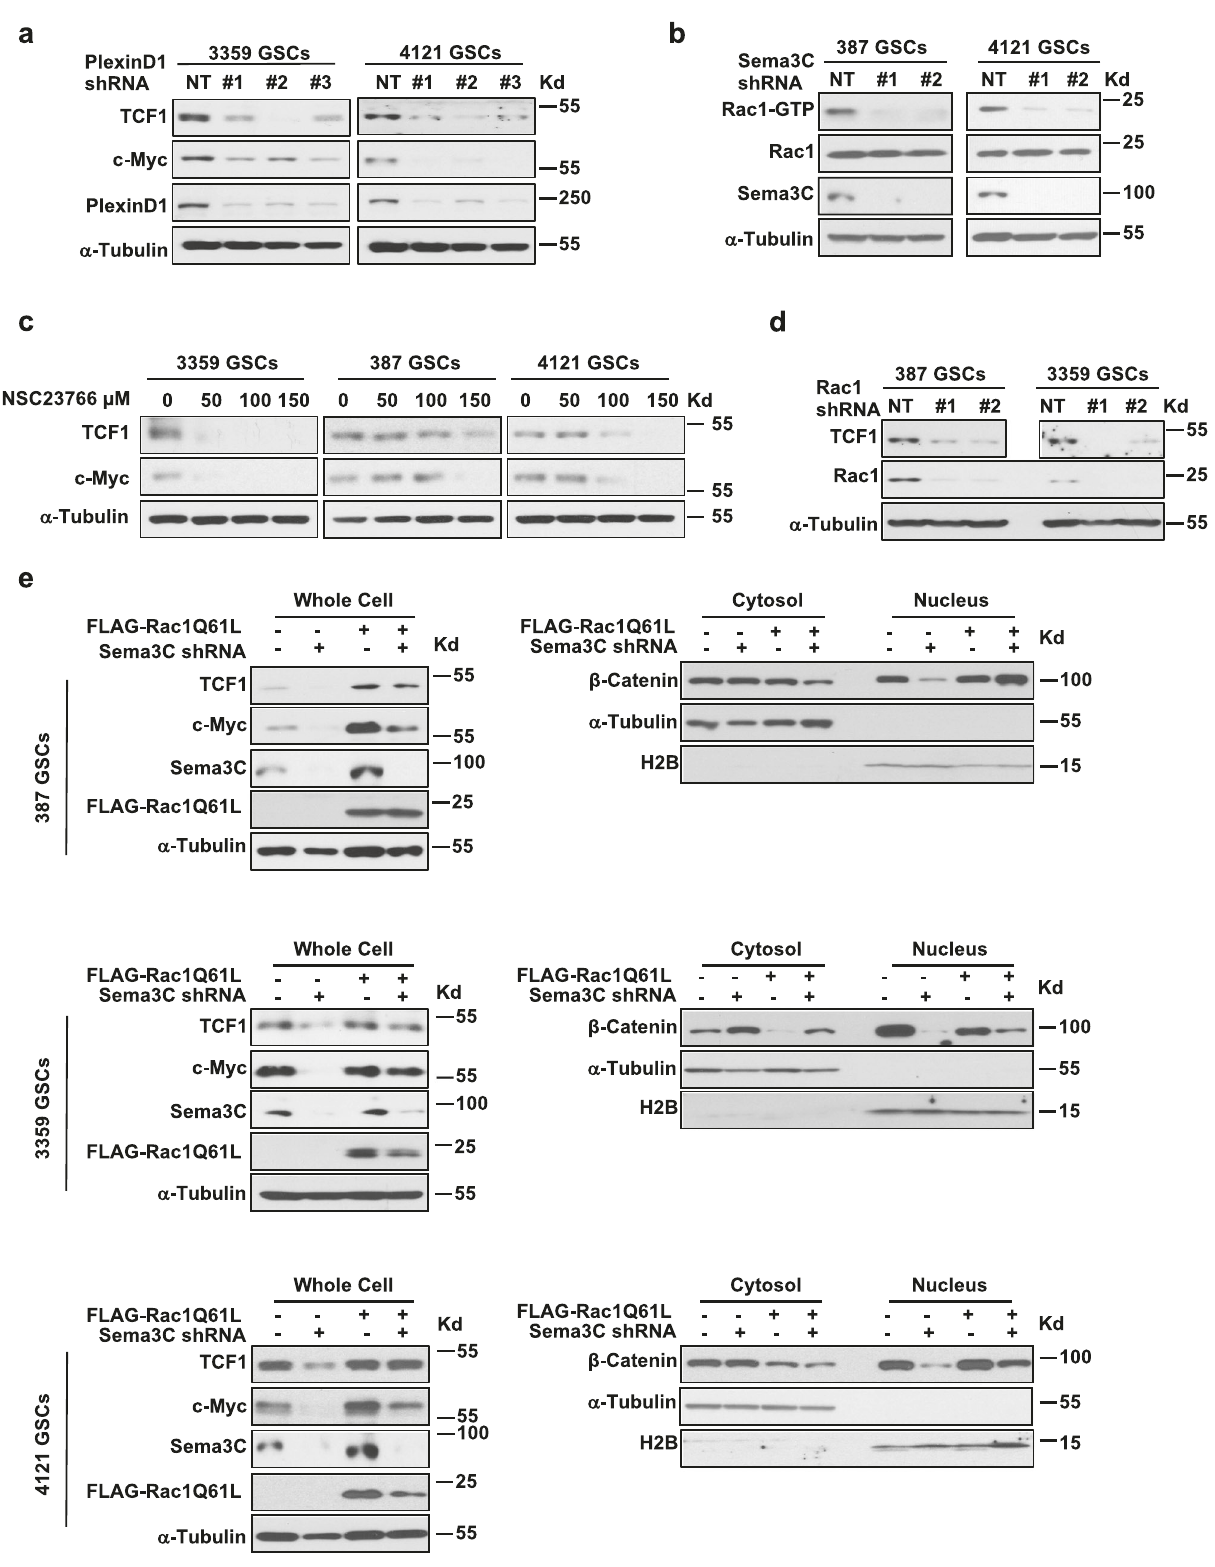
Fig. 5 | Sema3C induces nuclear β -catenin shuttling via Rac1 activation. a Western blots of TCF1 and c-Myc proteins after PlexinD1 knockdown in GSCs. b WesternblotsofRac1-GTPandRac1afterSema3CknockdowninGSCs. c Western blots of TCF1 and c-Myc in NSC23766-treated GSCs. d Western blots of TCF1 after